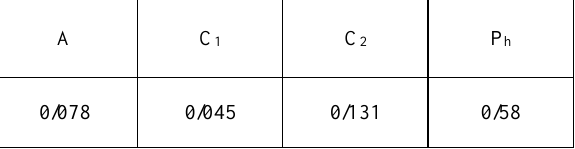
Table 1. Experimental initial values considered by Alexandridis et al